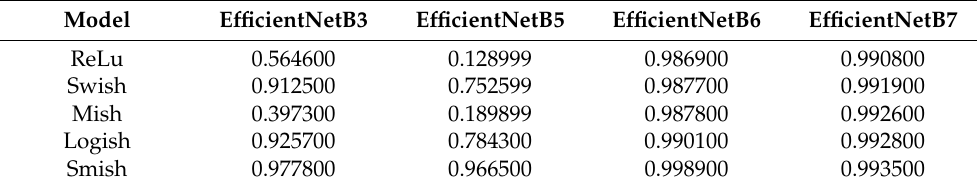
Table 3. Accuracy of EfficientNet models achieved via the five activation functions on Mnist.